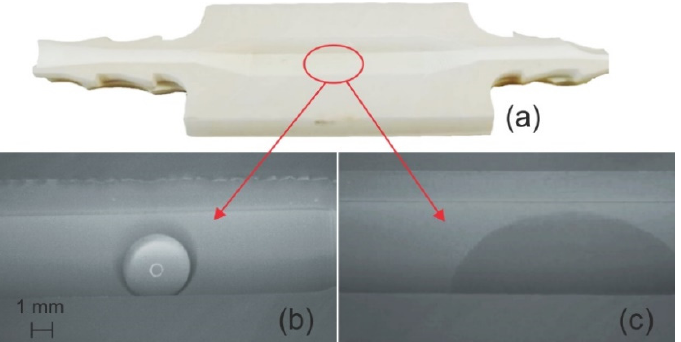
Figure 6. ( a ) Cross-sectional picture of the liquid cell fabricated with Rigid10K resin. Drop water on the inner surface ( b ) before and ( c ) after the post-treatment in a plasma chamber with O 2